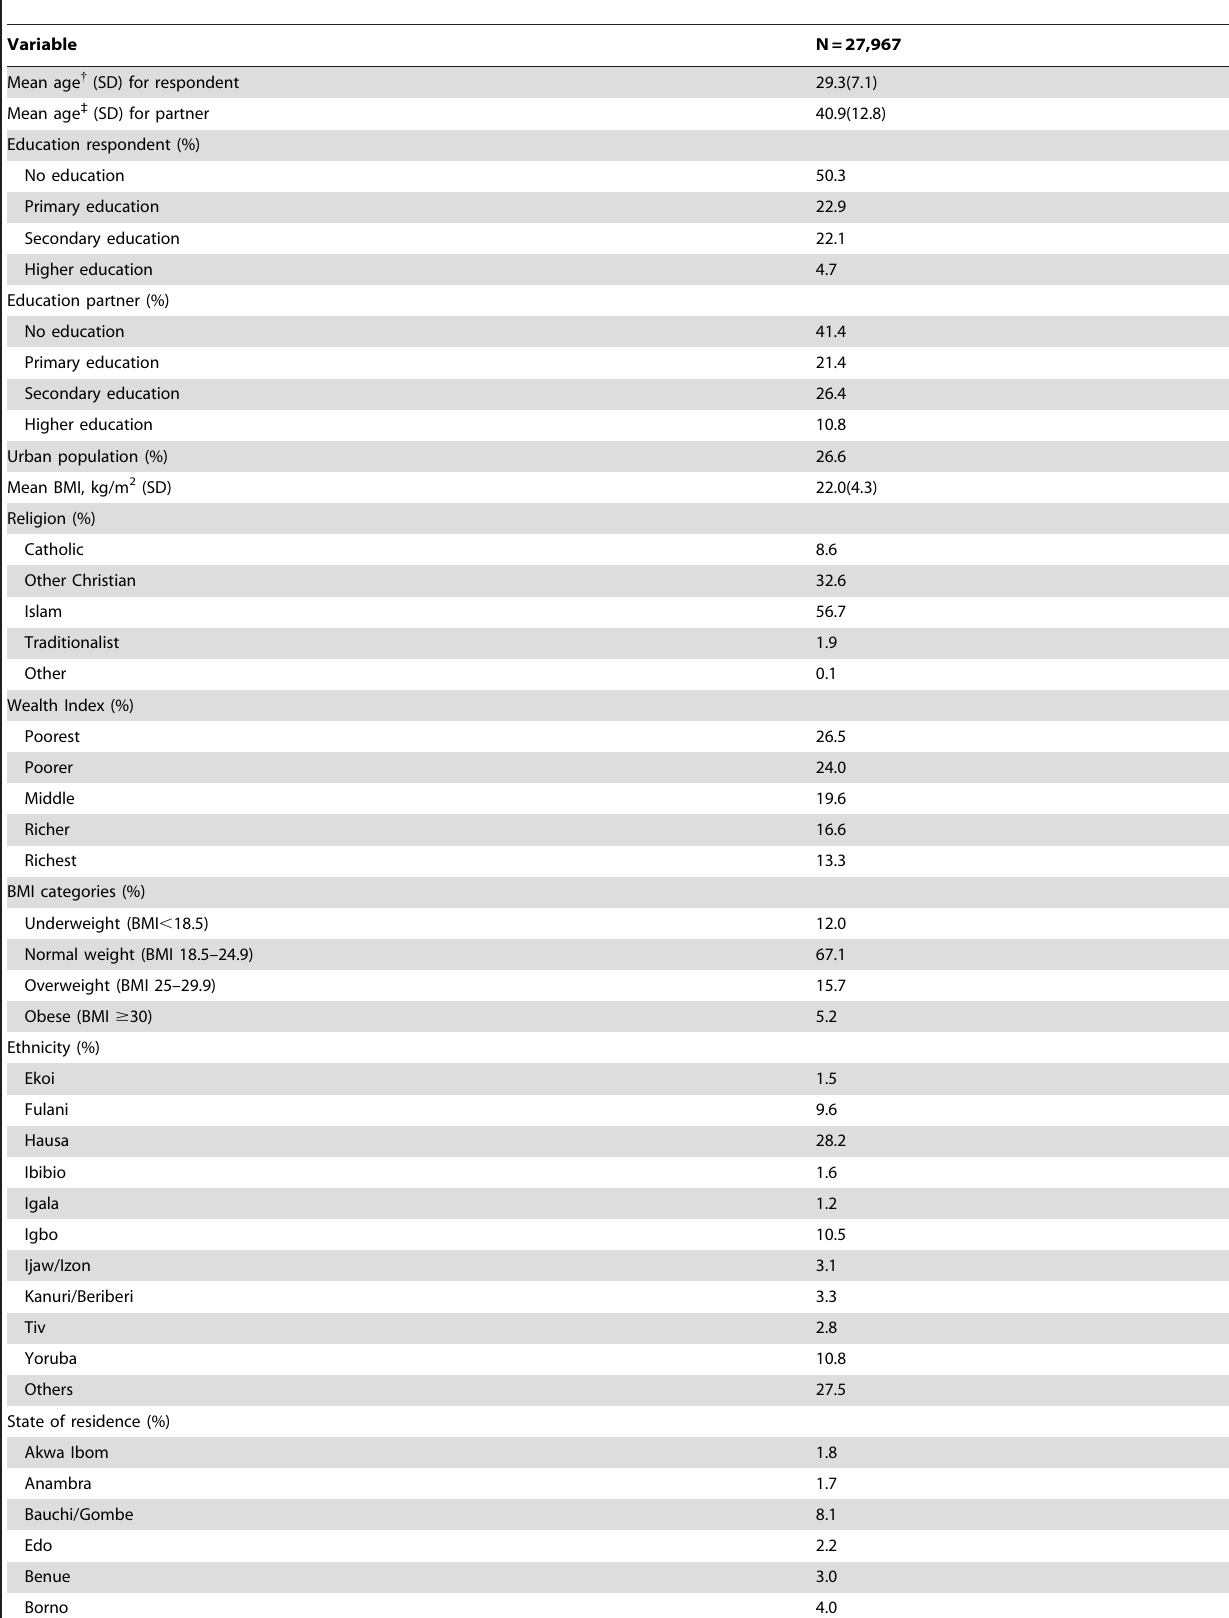
Table 1. Baseline characteristics of the study population (NDHS,